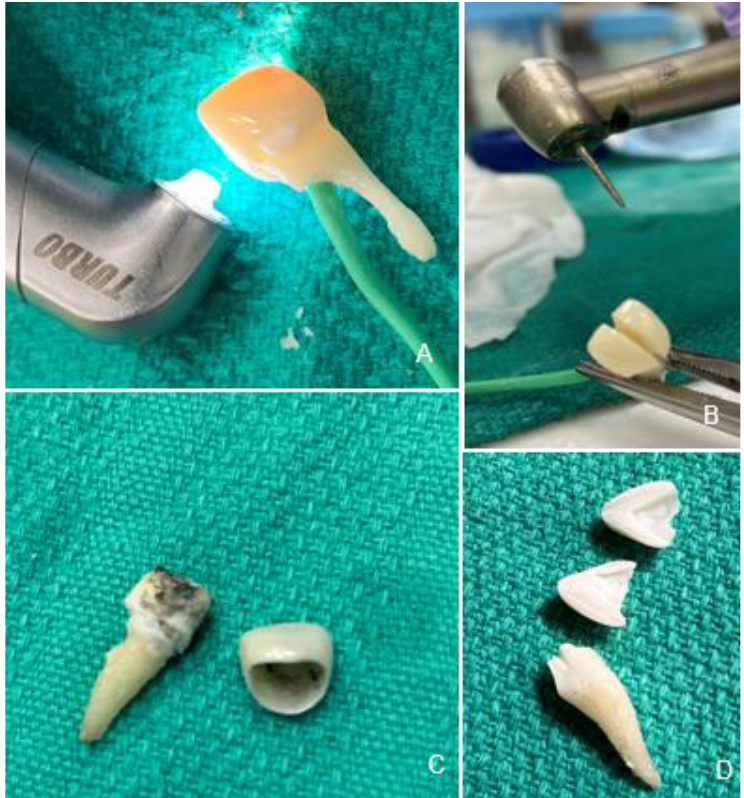
Figure 1. Experimental Procedures. Crown removal with Er,Cr:YSGG laser ( A ), and rotary handpiece ( B ). Laser retrieval results in an intact crown and charred cement covering dentin ( C ). Crown removed with a bur is destroyed with structural damage to the tooth ( D ).